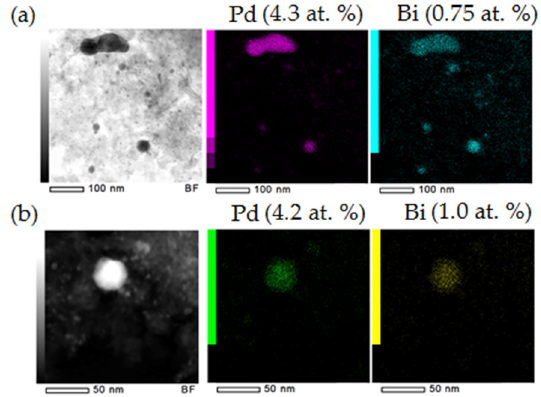
Figure 3 . Elemental mapping of the surface of the PdBi/Al 2 O 3 catalyst, obtained by EDS at ( a ) 400,000 × magnification and ( b ) 1,000,000× magnification.